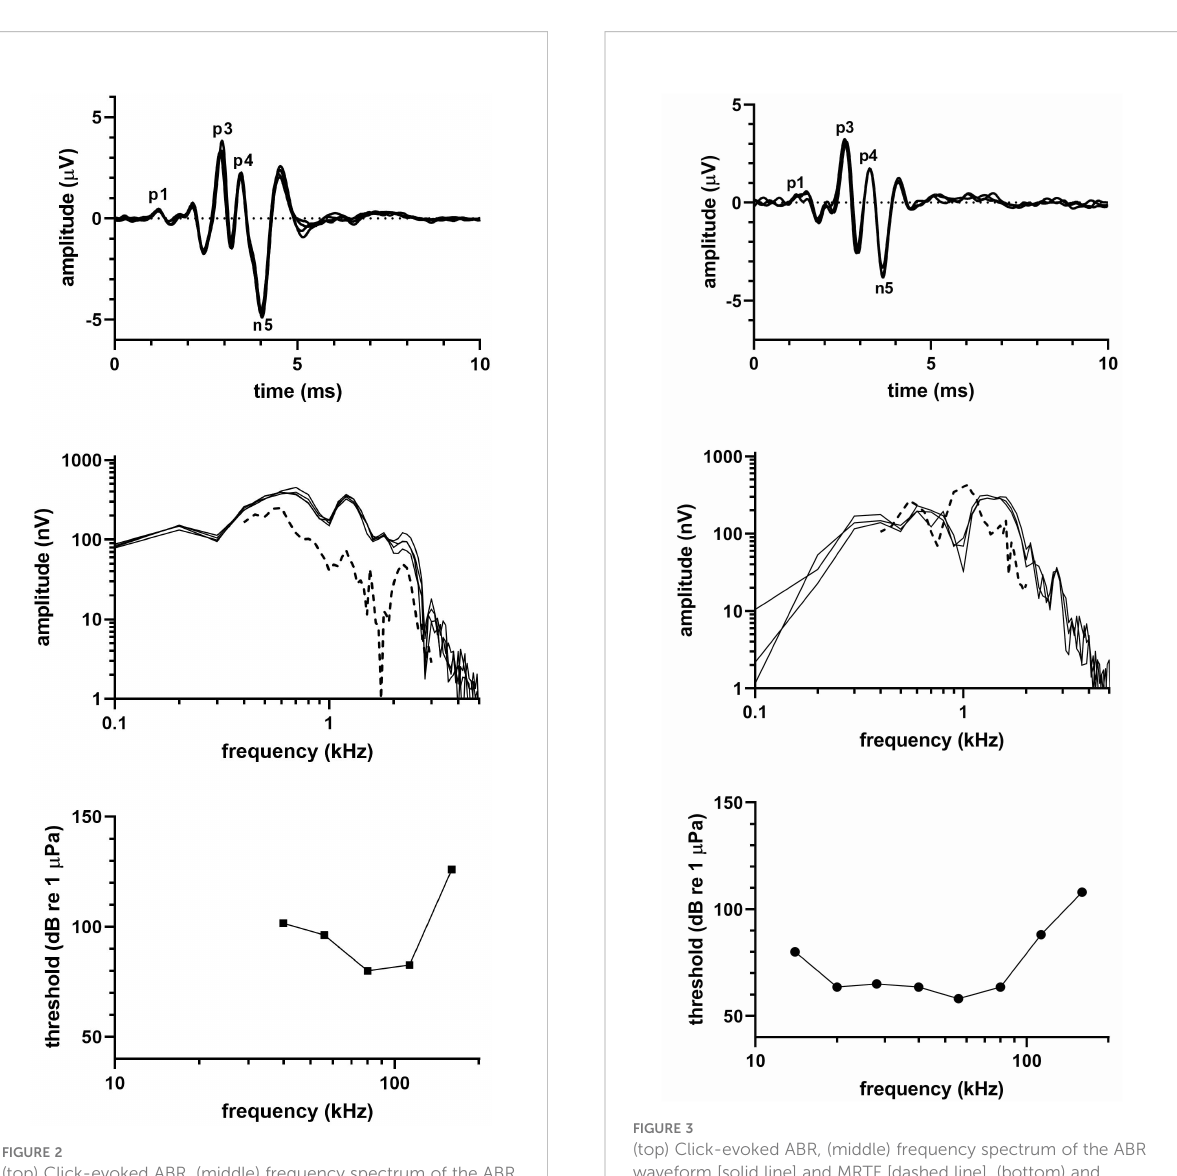
waveform [solid line] and MRTF [dashed line], (bottom) and audiogram for the pygmy sperm whale.